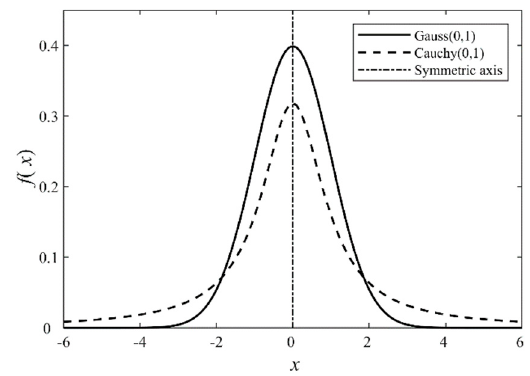
Figure 6. Gaussian and Cauchy distribution curves.